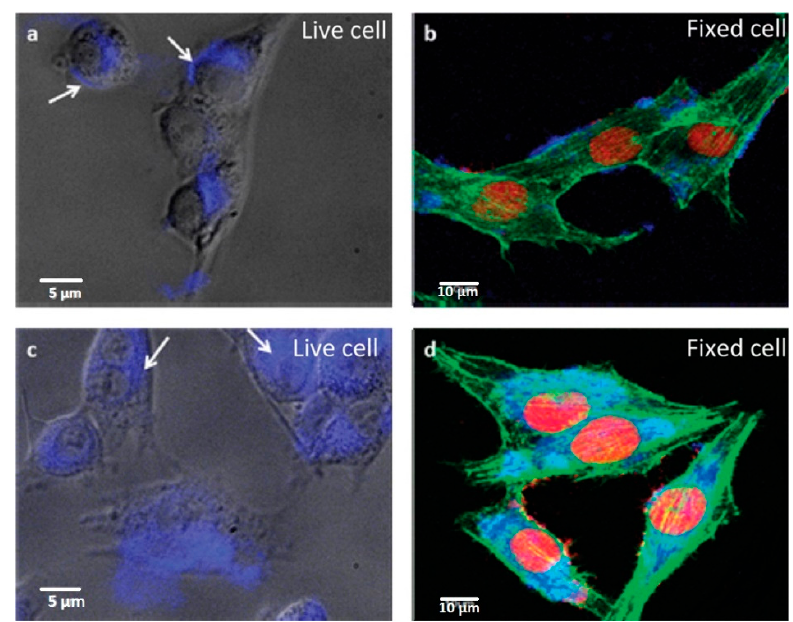
Figure 7. Real-time in situ detection of breast cancer cell surface integrin expression by the RGD–pyrene–GO probe: ( a ) probe fluorescence recovery by live MDA-MB-435 cancer cells which overexpress integrin avb3 on the cell surface. The recovered fluorescence is mainly detected on the cell membrane as indicated by white arrows; ( b ) probe fluorescence recovery by MDA-MB-435 cancer cells followed by 4% formalin fixing; ( c ) equivalent concentration of free RGD–pyrene incubated with liveMDA-MB-435 demonstrates significant endocytosis as indicated by white arrows; ( d ) equivalent concentration of RGD–pyrene incubated with MDA-MB-435 followed by 4% formalin fixing. Reproduced with permission [129]. Copyright 2012, Royal Society of Chemistry.